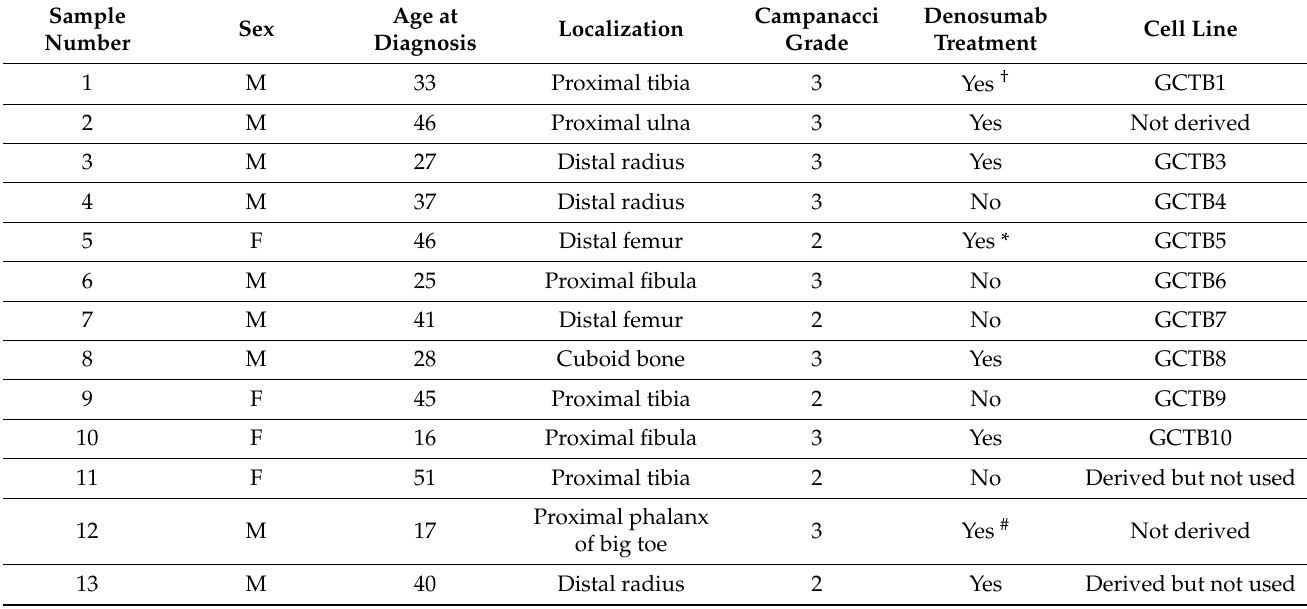
Table 1. Overview of the patients and samples included in this